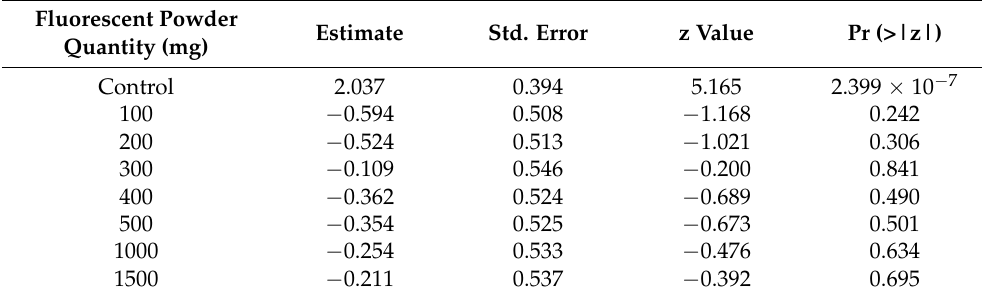
Table 2. Mixed-effect binomial model of male Aedes aegypti survival in function of fluorescent pow- der quantity.